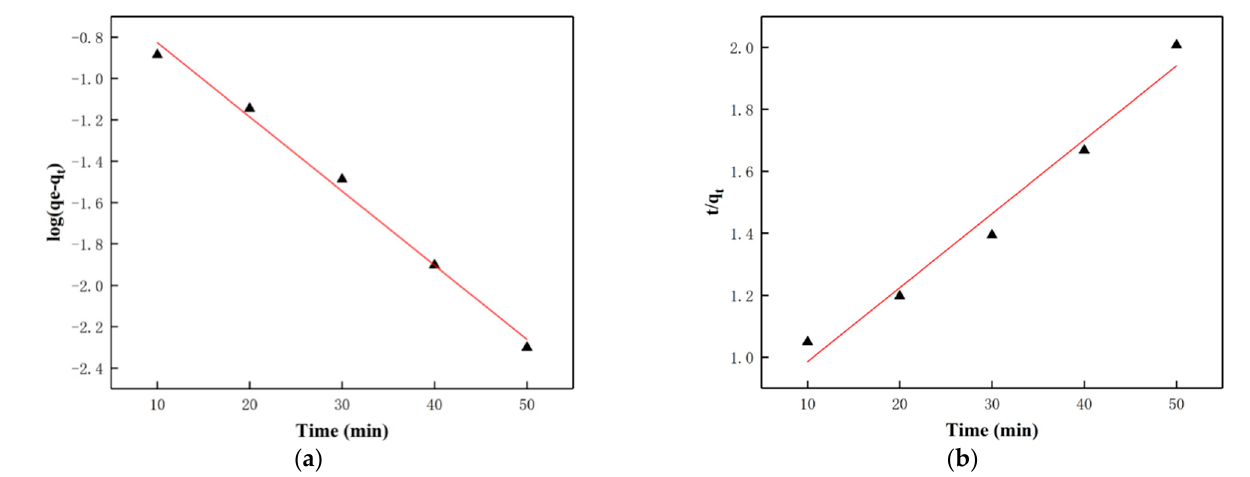
Figure 9. Corresponding linear fitting of AFB 1 adsorption by the modified PCL-g-C 3 N 4 /CQDs electrospun membranes with time, ( a ) pseudo − first − order model and ( b ) pseudo − second − order model. Table 1. Kinetics parameters for AFB 1 adsorption removal.